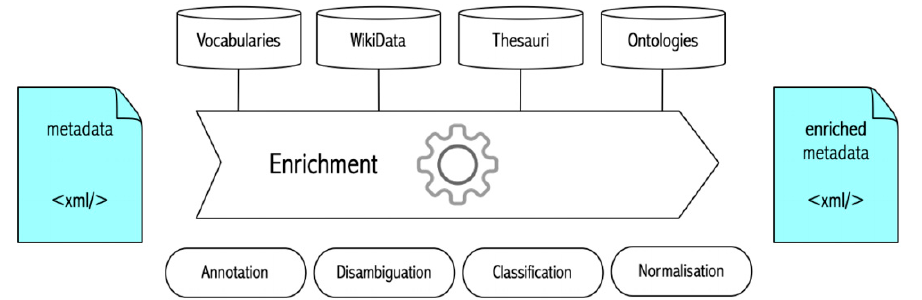
Figure 2. Metadata enrichment process.